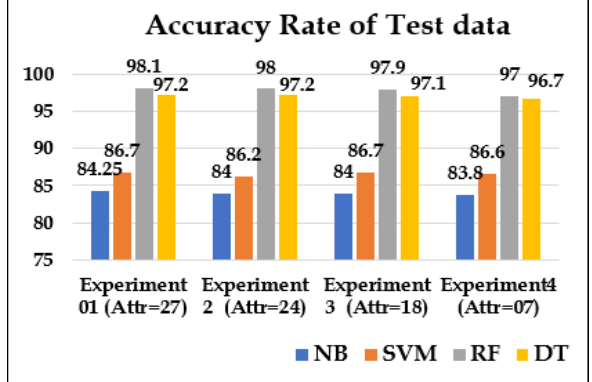
Figure 3. Accuracy Rate of Test Data.